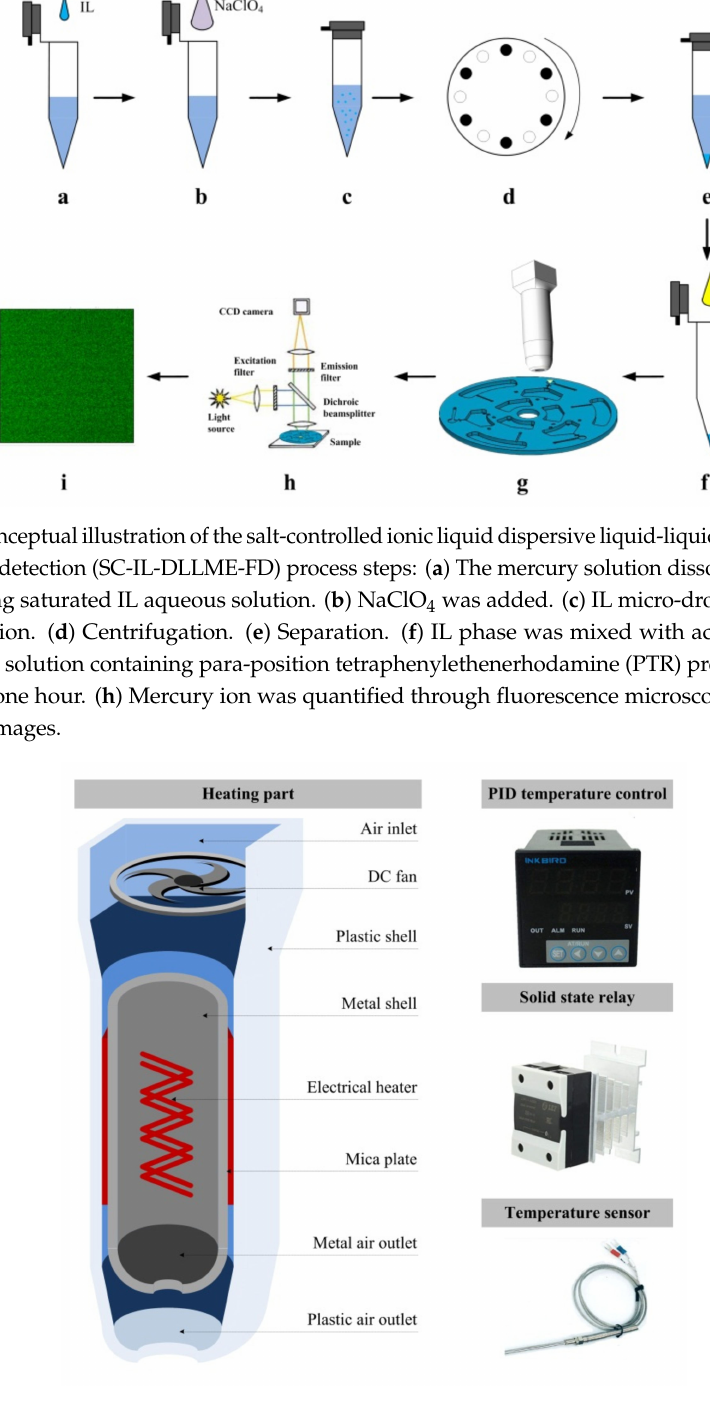
Figure 8. Schematics of the custom-built heating